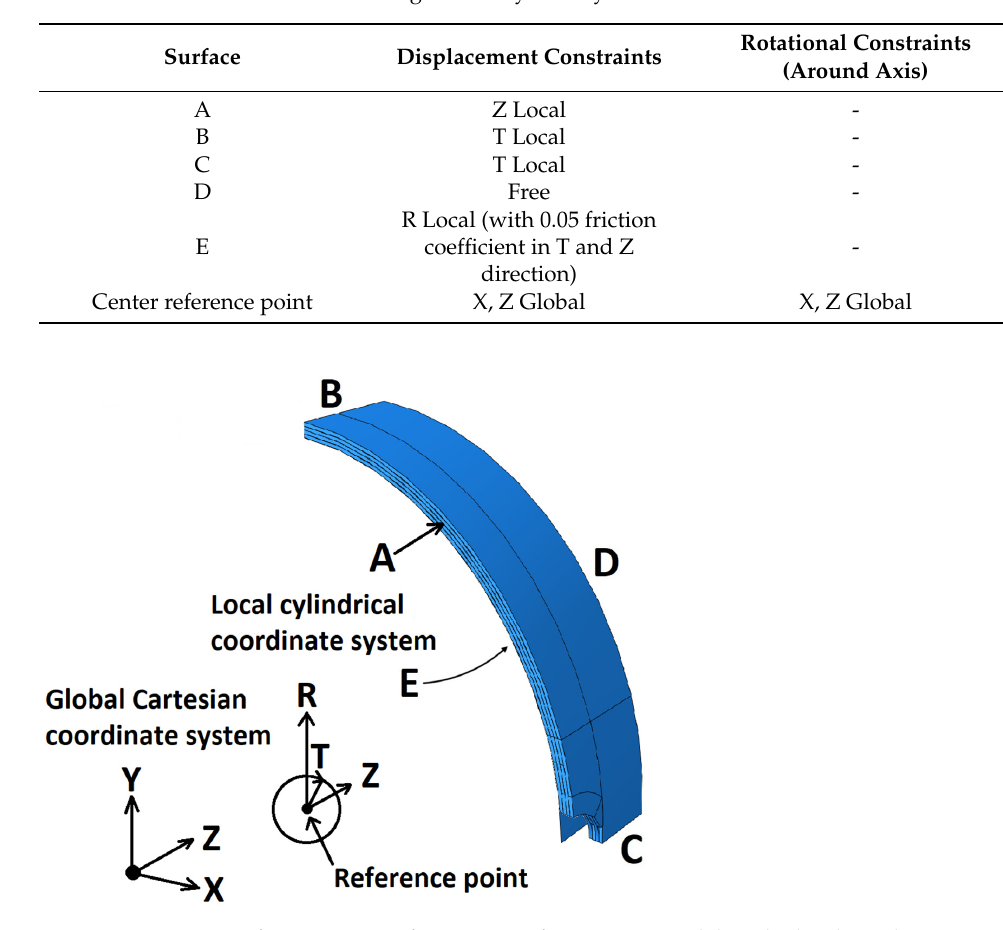
Figure 14. Detail of mesh in split disk model. To the left is from the middle axial layer, to the right is from the upper hoop layer. Table 3. Overview of constraints using normal symmetry.